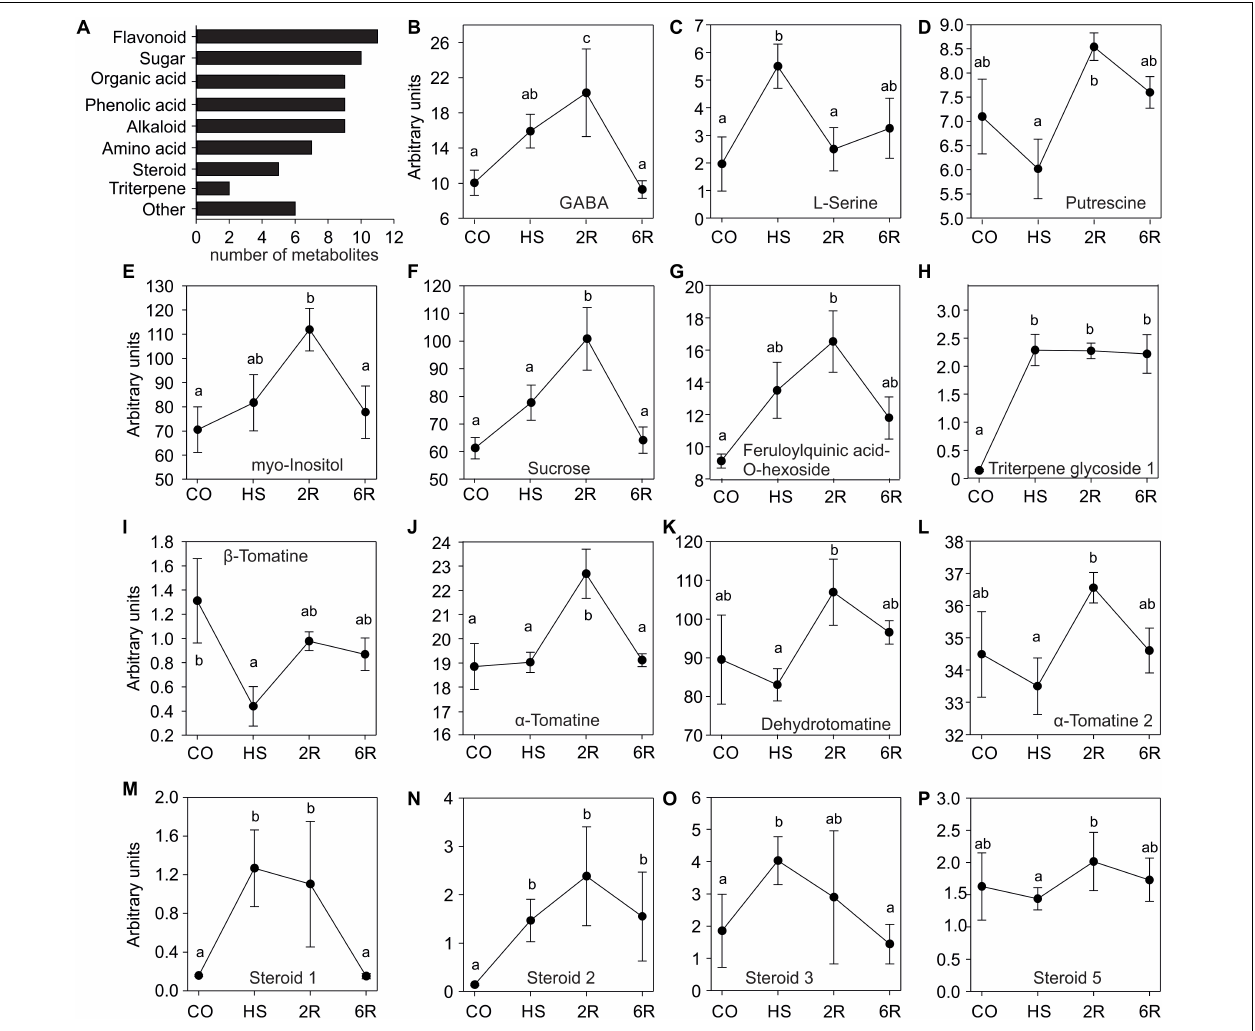
FIGURE 1 | Metabolite profile of wild-type tomato leaves exposed to HS. (A) Categories of metabolites identified in this study. (B–F) Primary and (G–P) secondary metabolite levels in leaves of plants exposed to 38 ◦ C for 1 h (HS), and then allowed to recover for 2 (R2) or 6 h (R6), or kept for the same time at 25 ◦ C as control sample (CO). Values are MS detector responses – arbitrary units and represent the average of four or five independent biological replicates ± SE. Letters denote statistically significant differences ( p < 0.05) based on one-way ANOVA and a post hoc Duncan